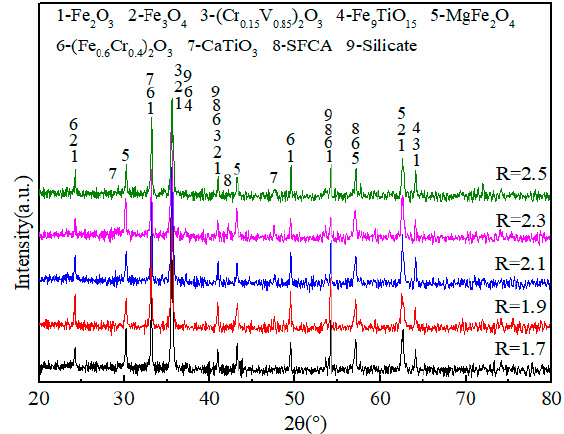
Figure 3. XRD pattern of HCVTM sinters with different basicity.